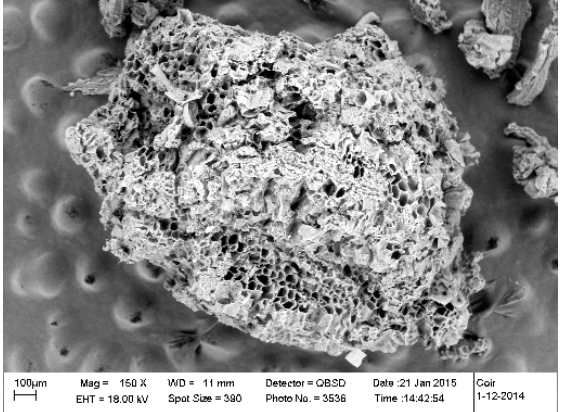
Figure 1. Scanning electron microscopic view of a coir particle.